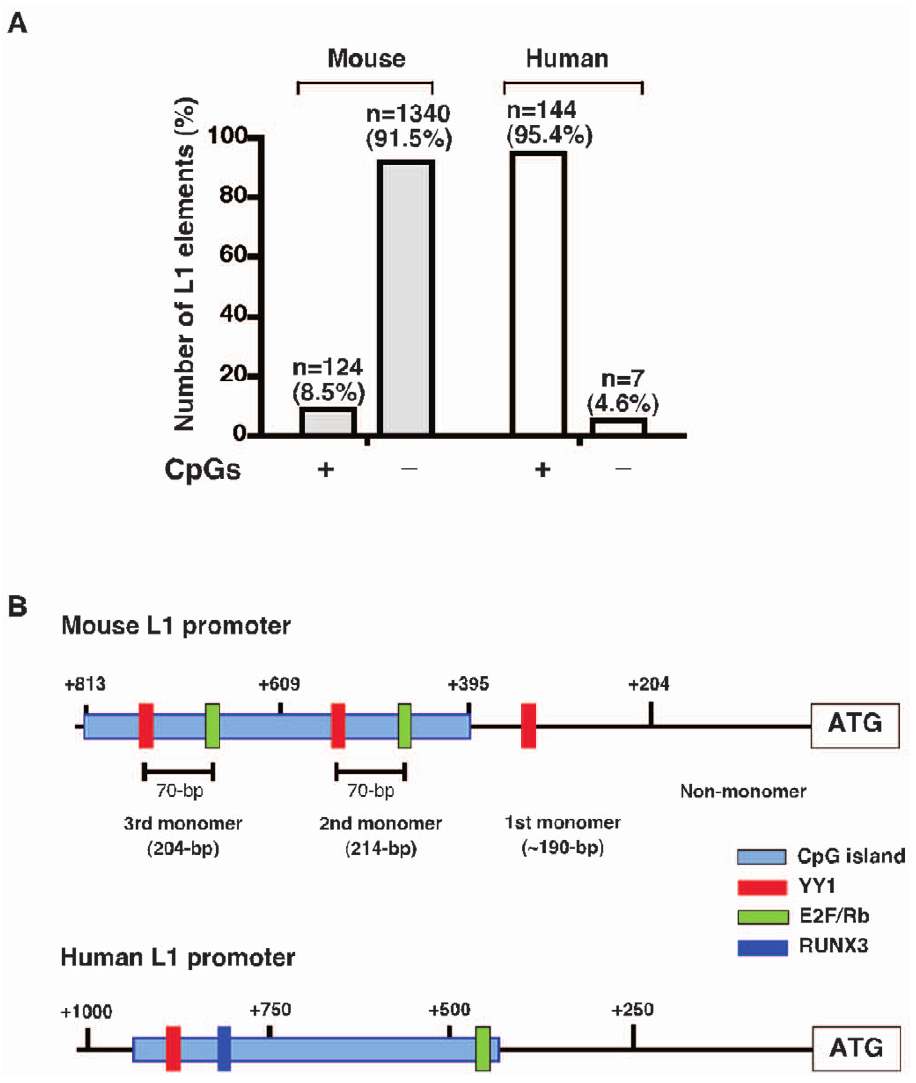
Figure 6. Characterization of the CpG islands in L1 promoter regions. ( A ) Comparative analysis of CpG island distributions in mouse and human L1 elements. ‘n’ represents the number of L1 elements. ( B ) Schematic representations of mouse and human L1 promoter regions. Vertical line above indicates the position and numbering of monomers; the box represents the transcription factors binding sites, YY1 (red), E2F (green), and RUNX3 (blue). The corresponding position of the CpG island in relation to start site ATG is illustrated by the light blue box.